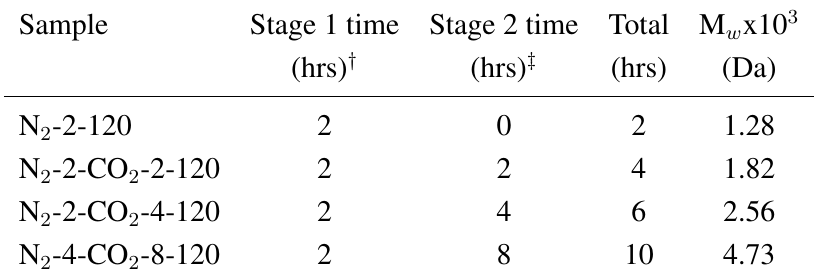
and CO at 120 ◦ C . Two-stage process. 2 2